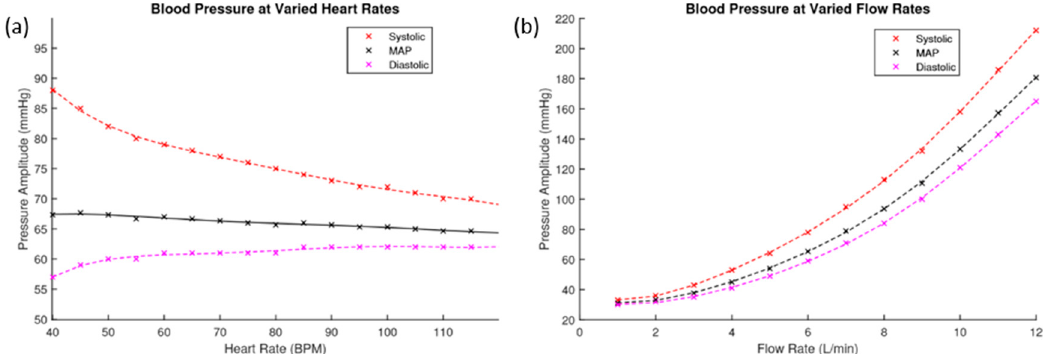
Figure 9. ( a ) This figure plots the blood pressure values pre-phantom against varied heart rates. ( b ) This figure plots the blood pressure values pre-phantom against varied flow rates.